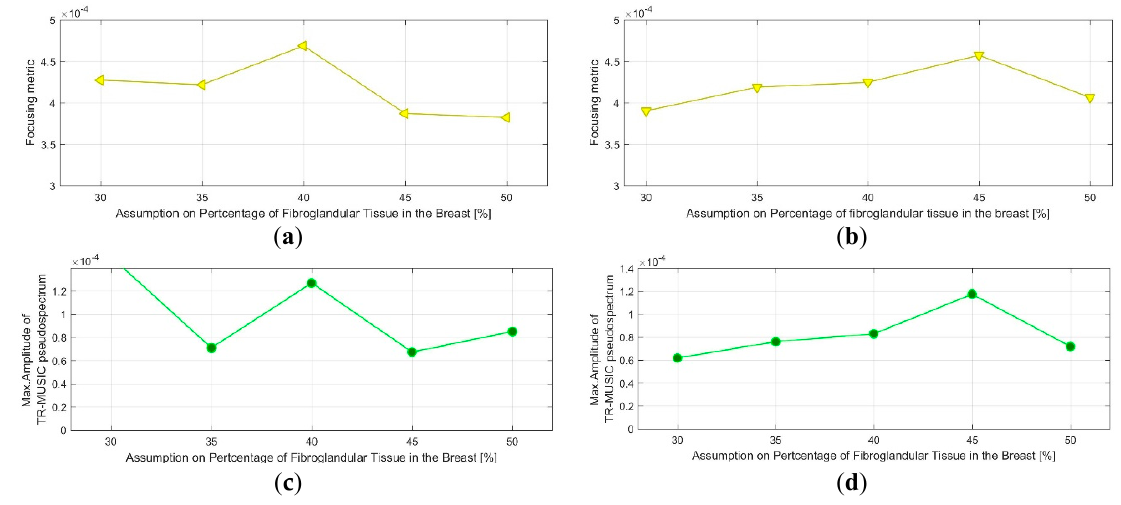
Figure 18. Breast rotational position #1: ( a ) Test Date 1, image quality assessment (QA) metric 1; ( b ) Test Date 2, image QA metric 1; ( c ) Test Date 1, image QA metric 2; ( d ) Test Date 2, image QA metric 2.